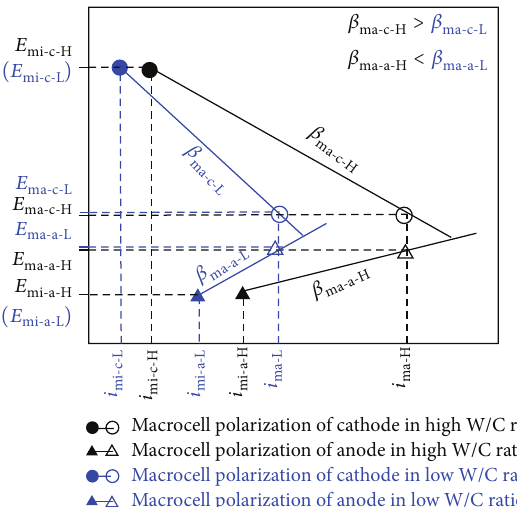
Figure 12: Mechanism of macrocell corrosion affected by water- cement